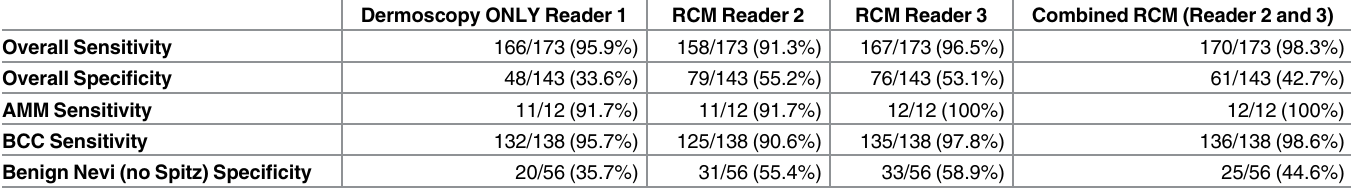
Table 1. Overall diagnostic performance of all readers.